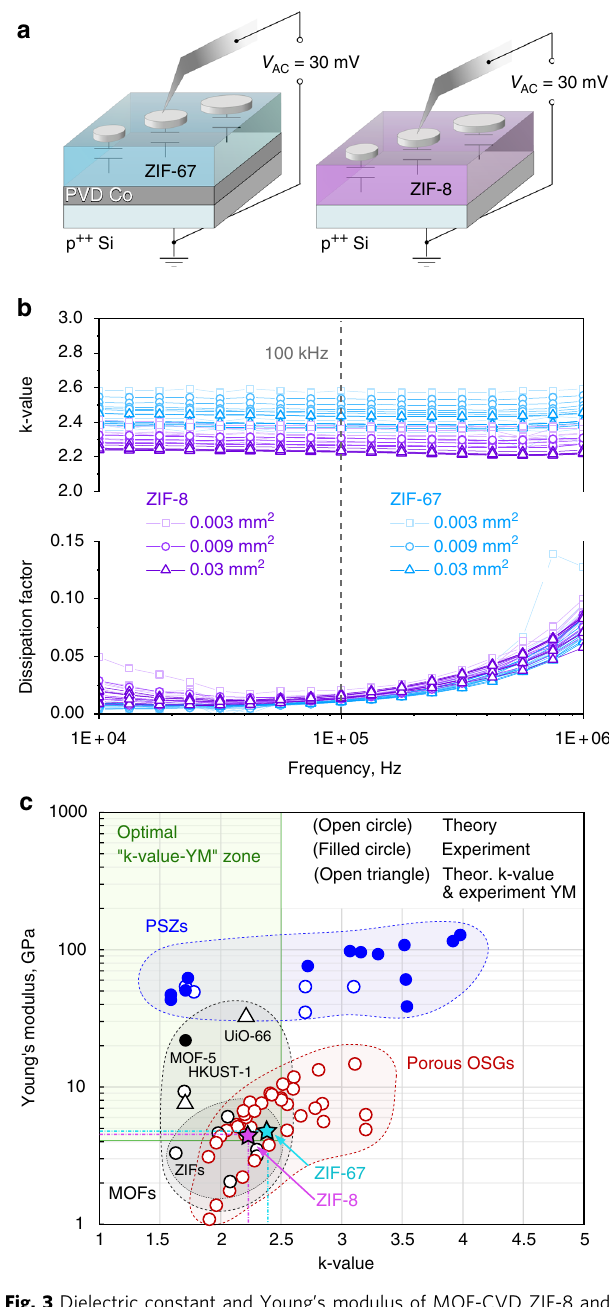
Fig. 3 Dielectric constant and Young ’ s modulus of MOF-CVD ZIF-8 and ZIF-67 fi lms. a experimental setup for k -value measurements. b k -value and dissipation factor spectra (10 kHz – 1 MHz) measured on MIM capacitors with three different top electrode areas. c Positioning of MOFs on the Young ’ s modulus/ k -value map in comparison with other classes of advanced low-k dielectrics. The Young ’ s modulus and k -value data measured on MOF-CVD ZIF-8 and ZIF-67 fi lms (this work) are marked with stars. The theoretical and experimental values for the Young ’ s modulus and k -value in the graph are taken from 31,56,63,72,74,86 –